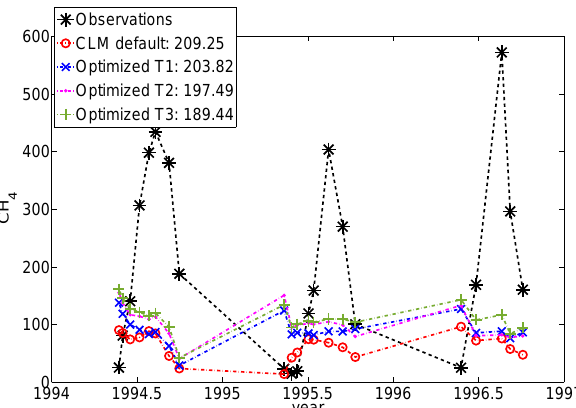
Figure 8. CH 4 emission observations and predictions when using the optimized parameters of optimization trials T1, T2, and T3, re- spectively, and when using the default parameters for the wetland site Alberta, Canada, for the real data case with d = 11 parameters. The legend shows the lowest RMSE value found in each trial.